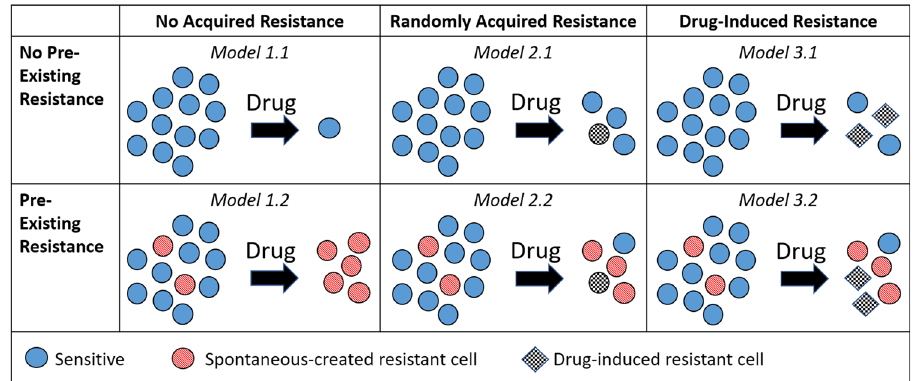
Fig. 1 Schematic illustrating the family of resistance models. Sensitive cells are illustrated as blue circles, pre-existing resistant cells as red- striped circles, spontaneously-created resistant cells as black-and-white checkered circles, and drug-induced resistant cells as black-and-white checkered diamonds. Second row contains all models without pre-existing resistance, and the third row contains all models with pre-existing resistance. Second column contains all models with no acquired resistance, third column contains all models with randomly acquired resistance, and fourth column contains all models with drug-induced